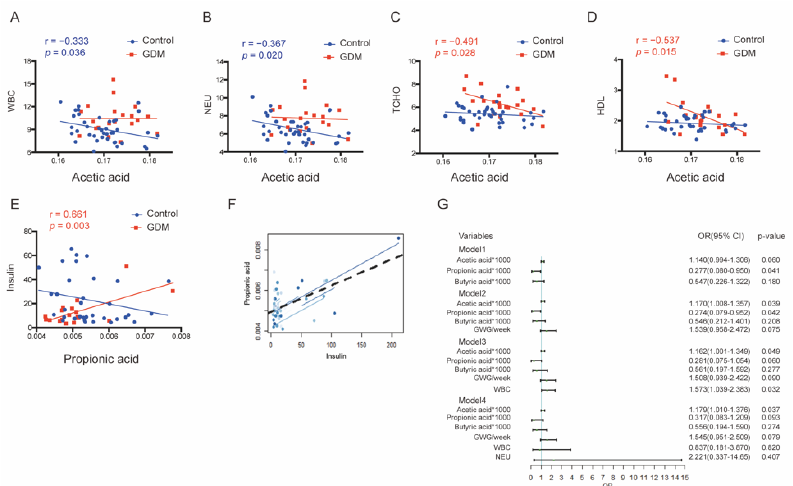
Figure 3. Correlation analysis between acetic, propionic, and butyric acid contents and clinical indicators in T2. ( A – D ) Associations between acetic acid and WBC, NEU counts, TCHO, or HDL levels in either group. ( E , F ) Associations between propionic acid and insulin levels. ( G ) Comparisons of GDM diagnostic models including acetic, propionic, butyric acid, and other parameters. WBC, white blood cell; NEU, neutrophil; TCHO, total cholesterol; HDL, high-density lipoprotein.